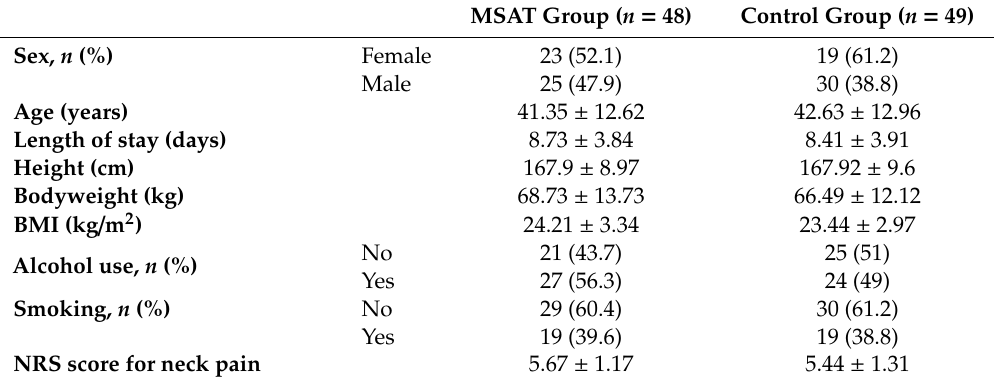
Table 1. Baseline characteristics of patients with acute whiplash injury treated by treatment